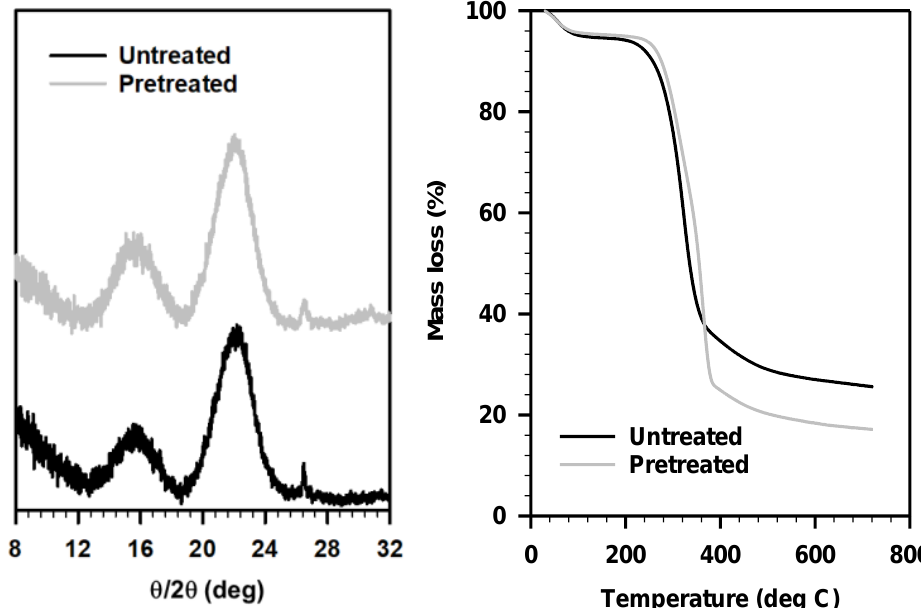
Figure 5. ( left ) Powder X-ray diffraction and ( right ) thermal gravimetric analysis, of untreated (black) and IL 2B pretreated (gray) sorghum biomass.